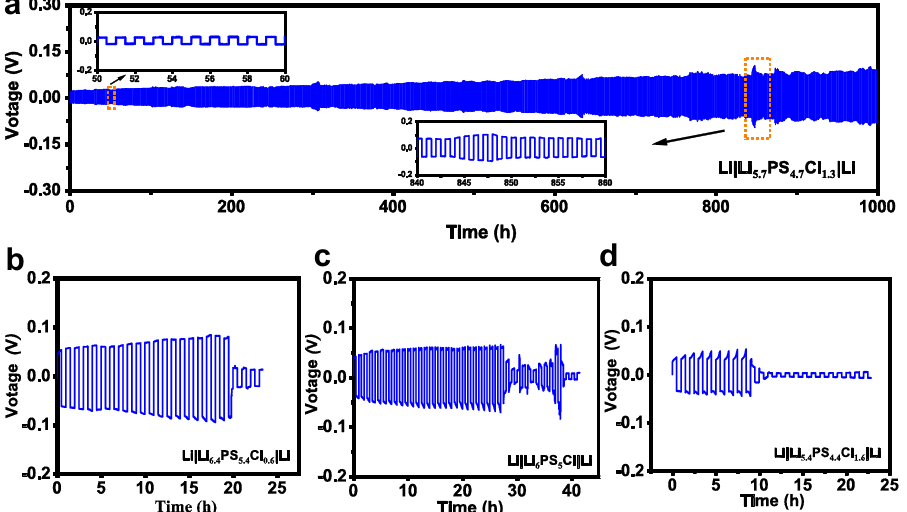
Fig. 5 Symmetric Li||Li cells cycling performance for SEs with different chlorine content. Li plating/stripping cycling on Li|SE|Li symmetric cells at 0.5 mA/cm 2 at 24 ± 4 °C using Cl-13 ( a ), Cl-06 ( b ), Cl-10 ( c ), and Cl-16 ( d ) SEs.